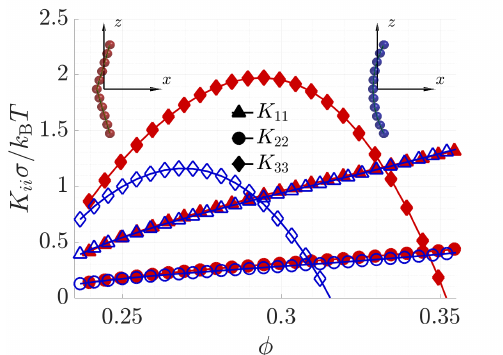
Figure 9. Elastic constants as a function of the volume fraction φ , for a nematic phase formed by obtuse angle V-shaped particles with a bend angle χ = 150 ◦ , red full symbols, and by the curved particles as shown in Figure 2c, blue empty symbols. (For the latter system, the φ scale is different from the one in Figure 1a of [37], since in that case, the volume fraction was calculated as φ = v eff ρ